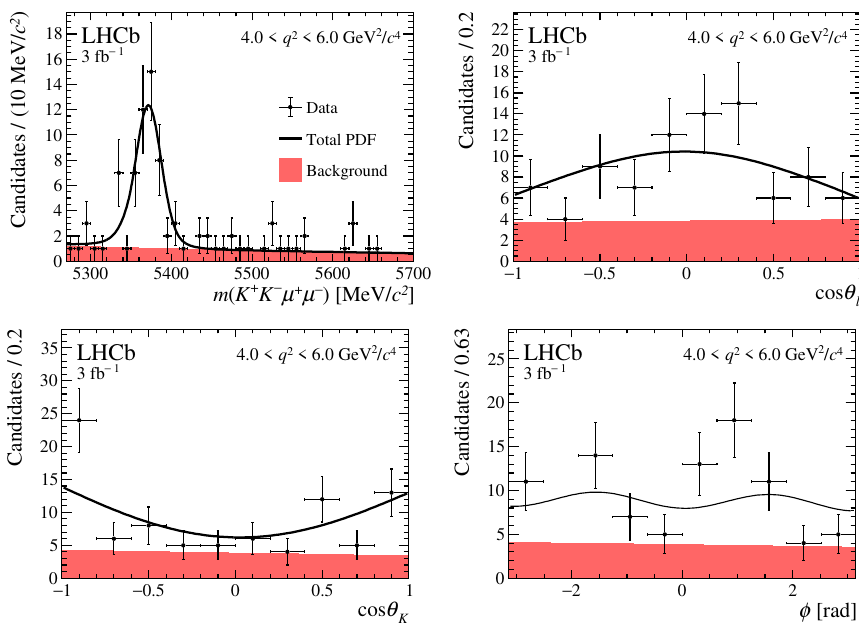
Figure 18 . Mass and angular distributions of B 0 4 . 0 < q 2 < 6 . 0 GeV 2 /c 4 for data taken in 2011–2012. The data are overlaid with the projections of the fitted PDF.